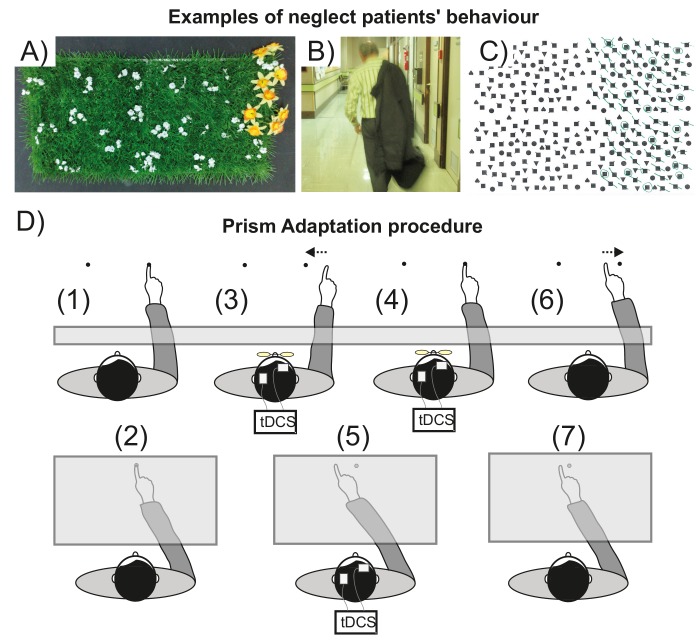
Visuospatial neglect and prism adaptation.(A–C) Examples of neglect behavior by patients in the present study. (A) Gardening task: arrange the flowers uniformly around the garden; (B) patient has neglected the left of his body; (C) Ota-Girardi task: cancel all targets on the page. (D) Prism Adaptation. (1) Baseline: visual feedback. Participants make rapid centre-out pointing movements to targets located at 10 degrees left or right. Vision of the hand start position is occluded. (2) Baseline: no visual feedback. Participants point at a central target. Vision of the hand is occluded throughout. (3) Adaptation: early prism exposure. Participants repeat (1) wearing 10° right-shifting prisms and initially make large rightward pointing errors. They use error feedback to correct their movements from right to left. (4) Adaptation: late prism exposure. After sustained prism exposure participants successfully realign hand-eye coordination leftward to regain baseline accuracy (i.e. they adapt). (5) Adaptation: prism after-effect. As participants adapt, this induces a leftward bias (prism after-effect), measured as the change from baseline (2). (6) Washout. After prism removal when participants point as in (1), the effect of adaptation is seen as a leftward error that is quickly corrected to restore baseline accuracy. (7) Retention. The magnitude of any remaining prism after-effect is measured as in (2).